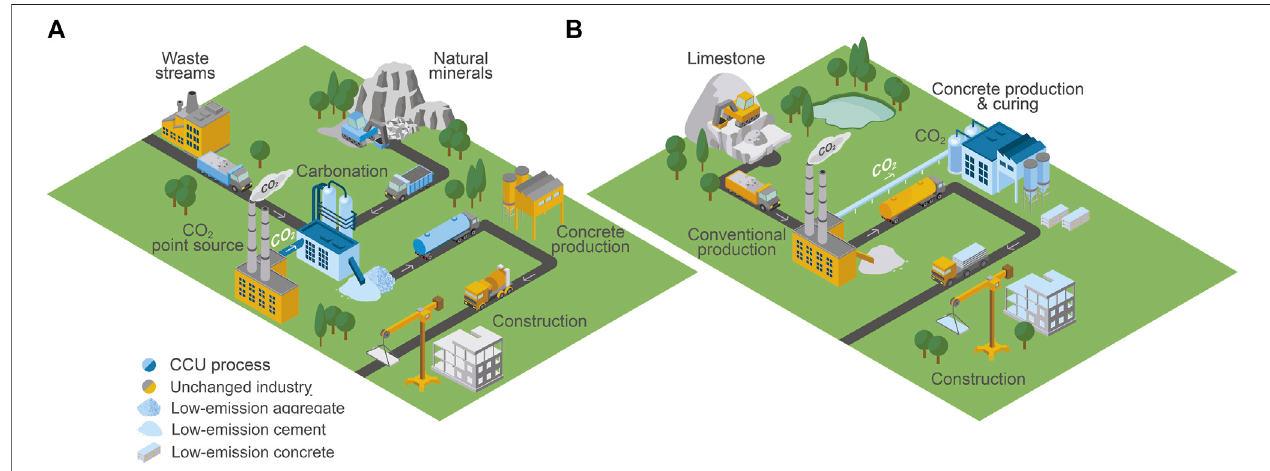
FIGURE 1 | CO 2 mineralization concepts in the cement and construction industry. (A) : Carbonation of minerals or wastes (B) : CO 2 curing of concrete.